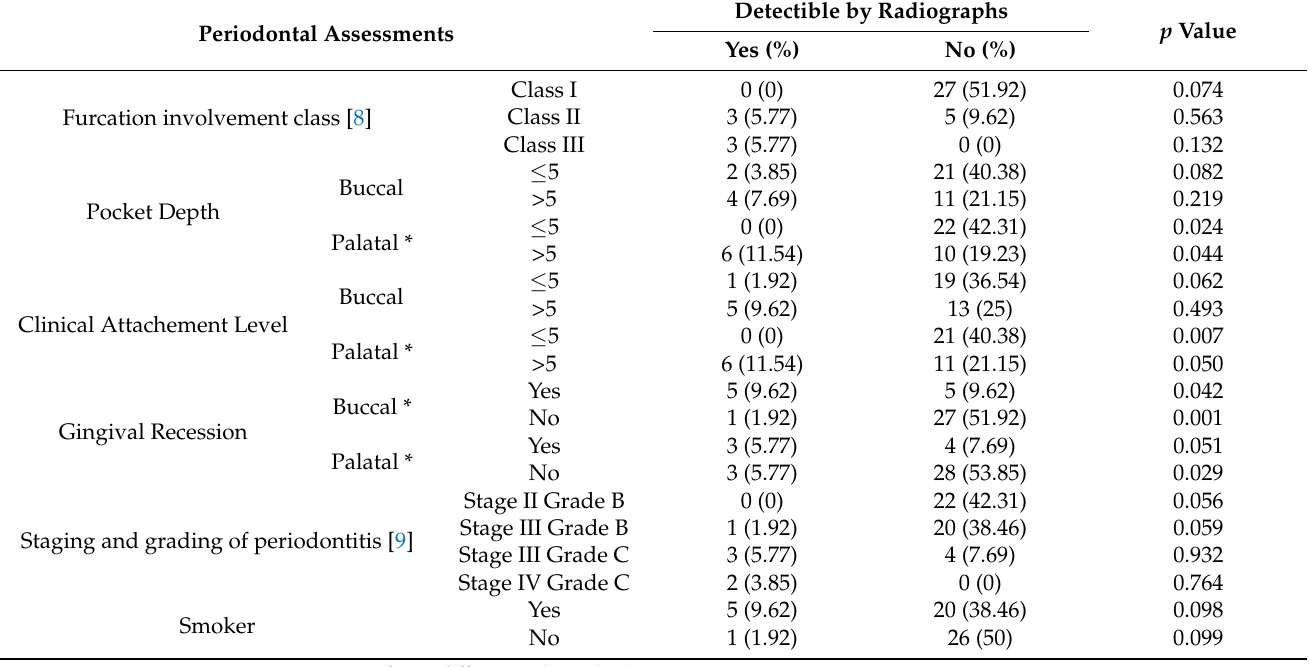
Table 2. Relation between the Class of furcation and other periodontal data to the radiographic detectability of furcation for